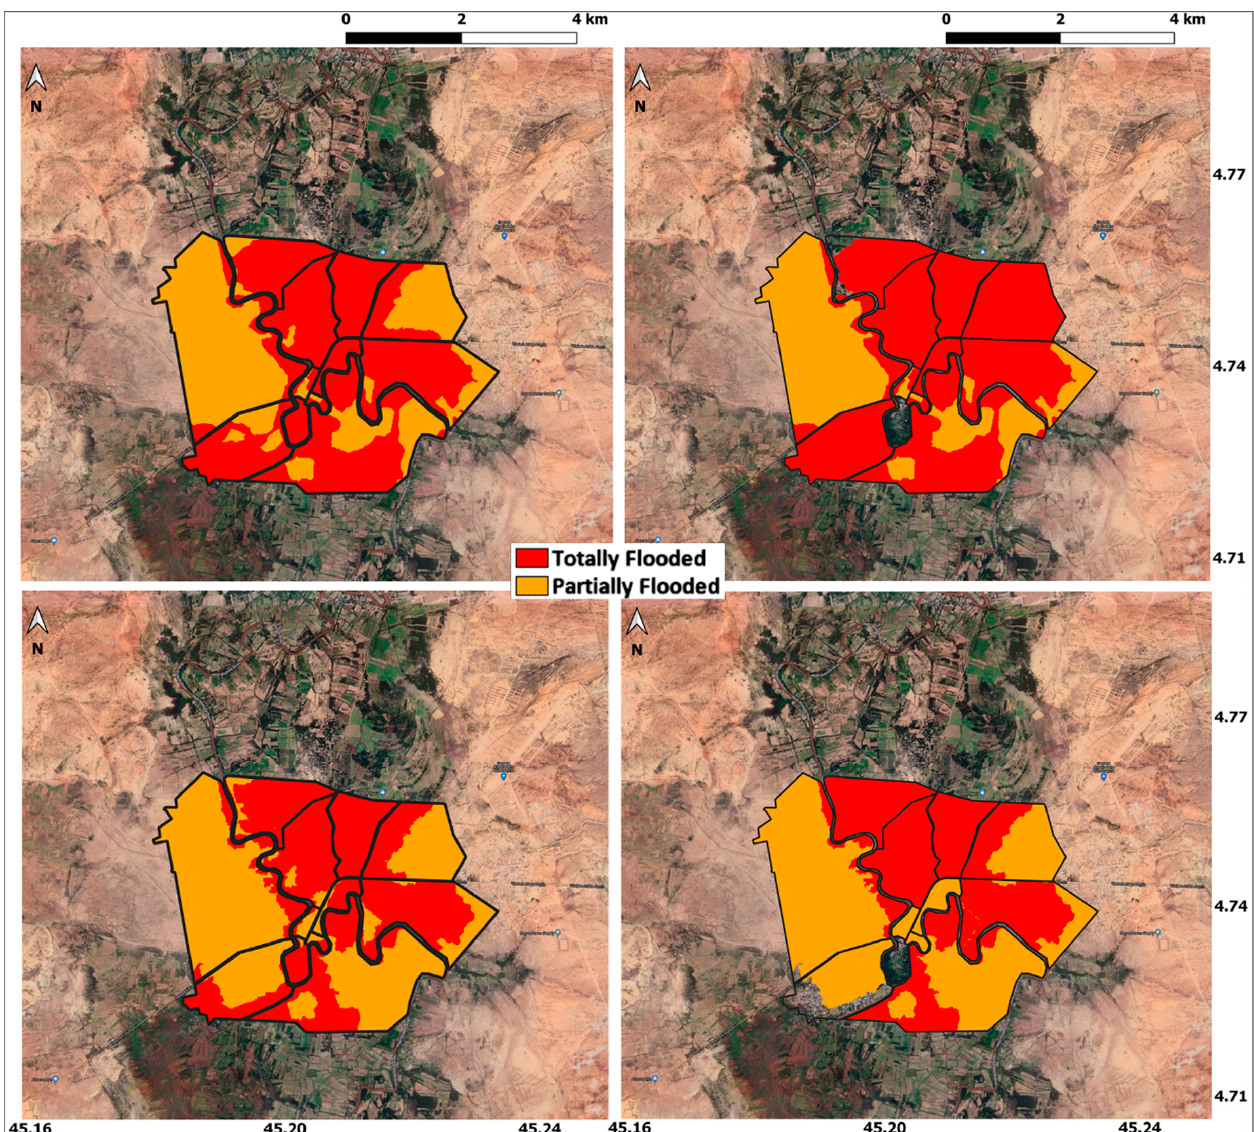
Figure 9. Comparison between the UNOSAT-derived reference maps (upper left: October–November 2019, lower left: April–May 2020) and PSperc-derived maps (upper right: pair 6–30 October, 2019, lower right: 9–21 May, 2020). The boundaries of the districts shown in Figure 1 are highlighted in black. Table 2. Results of the comparison between UNOSAT-derived maps and PS-derived maps for the flood that occurred in October November 2019. OA: overall accuracy. Columns represent classes